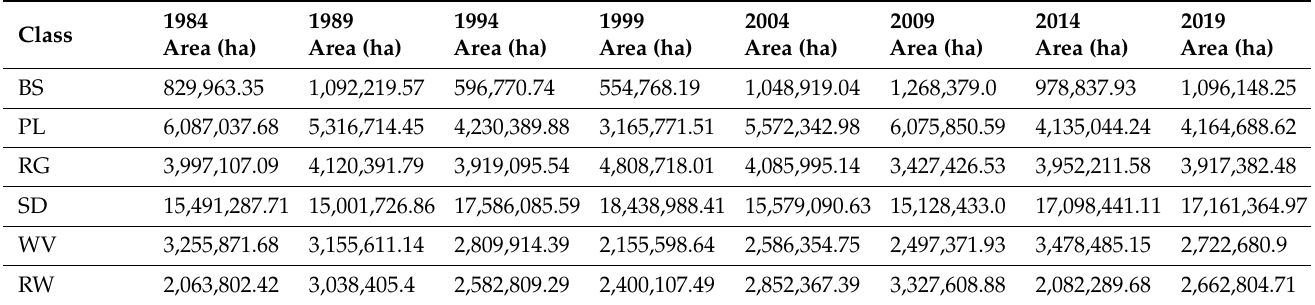
Table 2. Area coverage in hectares of rainfed agriculture and other LULC classes for the period between 1984 and